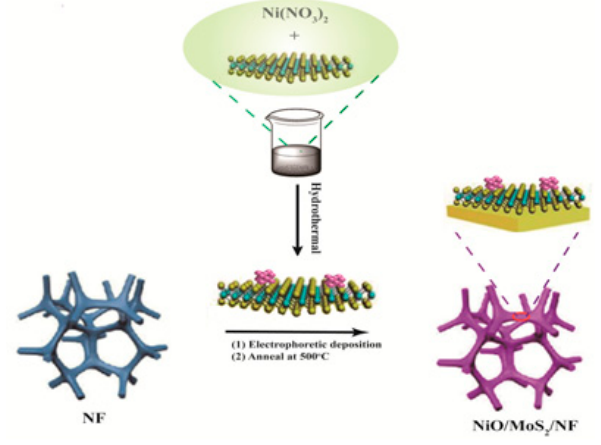
Scheme 1. Schematic of the synthesis of a synergetic NiO / MoS 2